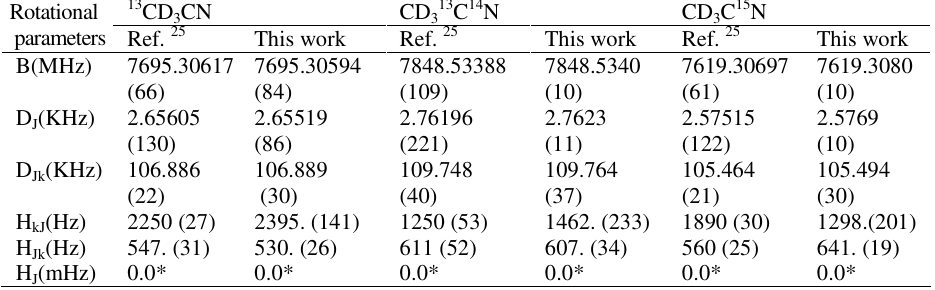
C 15 N with 3 15 N Rotational 3 C